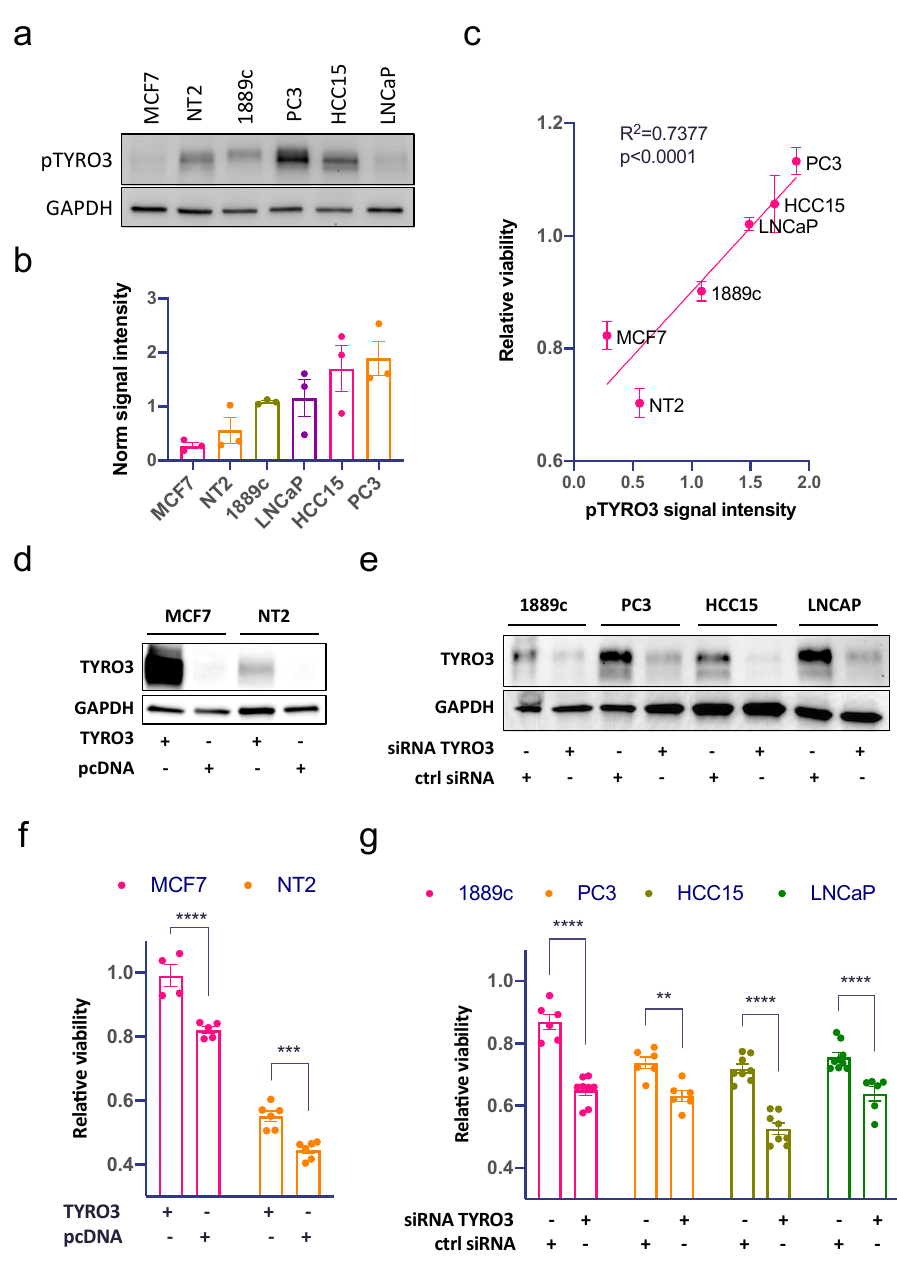
Figure 4. TYRO3/Dtk activity correlates with sunitinib response. ( a ) Western blot analysis of activated TYRO3/Dtk and ( b ) quantification of the TYRO3/Dtk phosphorylation signal in six cell lines (MCF-7, NT2, 1889c, PC3, HCC15, and LNCaP). ( c ) Correlation of averaged TYRO3/Dtk activity with sunitinib response in the same cell lines. ( d ) Overexpression of TYRO3/Dtk in MCF-7 and NT2 and ( f ) their relative sunitinib response compared to the native cells. ( e ) Knockdown of TYRO3/Dtk by siRNA in 1889c, PC3, HCC15, and LNCaP and ( g ) the significantly increased sunitinib sensitivity of specific siRNAs in comparison to the siRNA control (** p < 0.01, *** p < 0.001, **** p < 0.0001). The uncropped blots are shown in Figure S8.